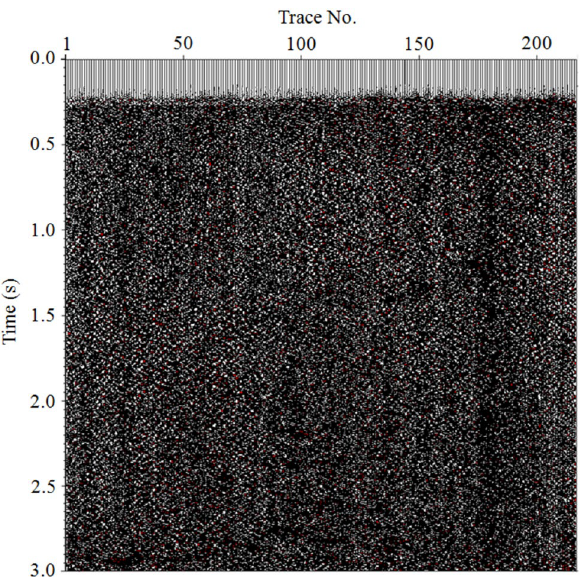
Fig. 20 Removed noises (the difference plot between Figs. 14,